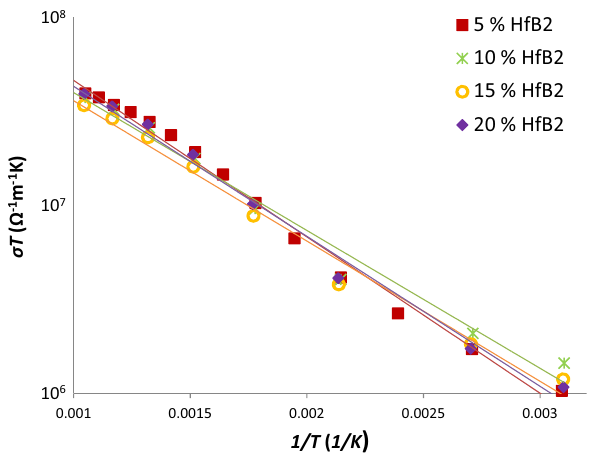
Fig. 7 Plot of ln( r T ) versus reciprocal temperature of boron carbide/ HfB 2 composites for various sample compositions